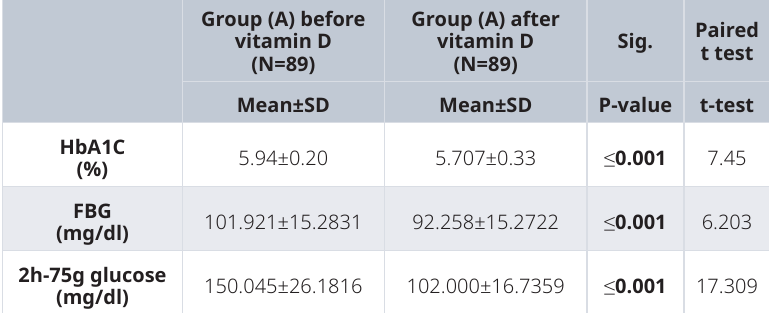
Table 3. Comparison of prediabetic patients with PN before and after Vitamin D Supplementation (Group A). Group (A) before vitamin